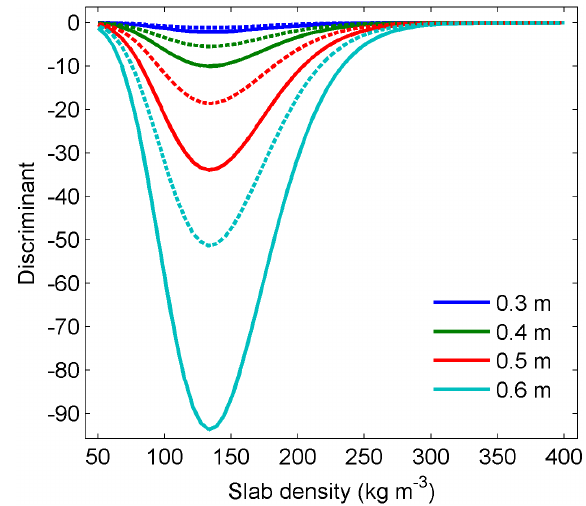
Figure 5. The polynomial’s (Eq. 5) discriminant vs. slab density for typical values of slab thickness (colors); different line styles in- dicate flat terrain (dashed) and a slope inclined by α = 38 ◦ (solid